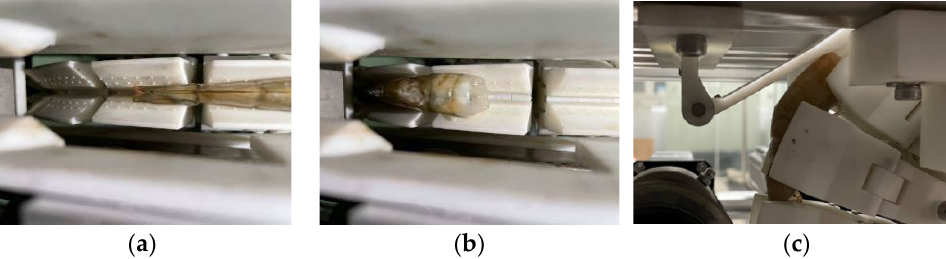
Figure 22. Shrimp clamping process: ( a ) feeding, ( b ) start of clamping, and ( c ) end of clamping.